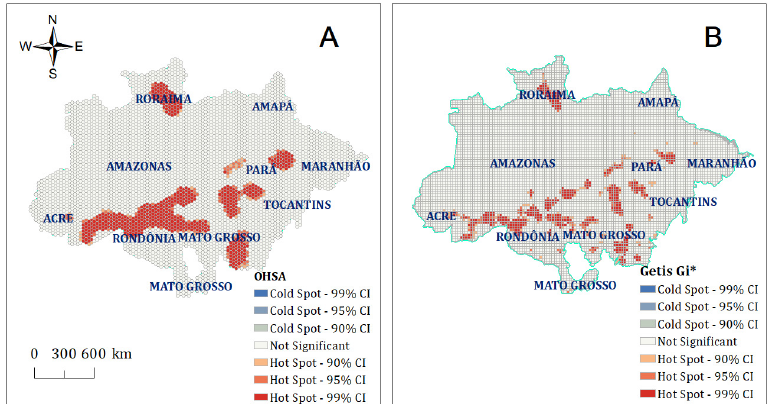
Figure 5. Hotspot analysis. ( A ) OHSA in the hexagon grids, ( B ) Getis-Ord Gi* hotspot analysis in the fishnet grids.